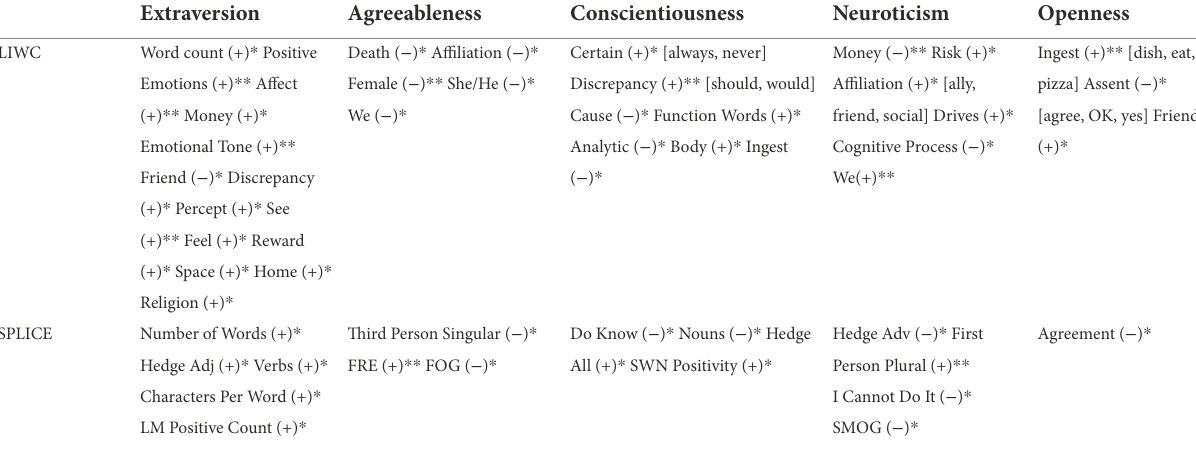
TABLE 3 Regression results for LIWC and SPLICE